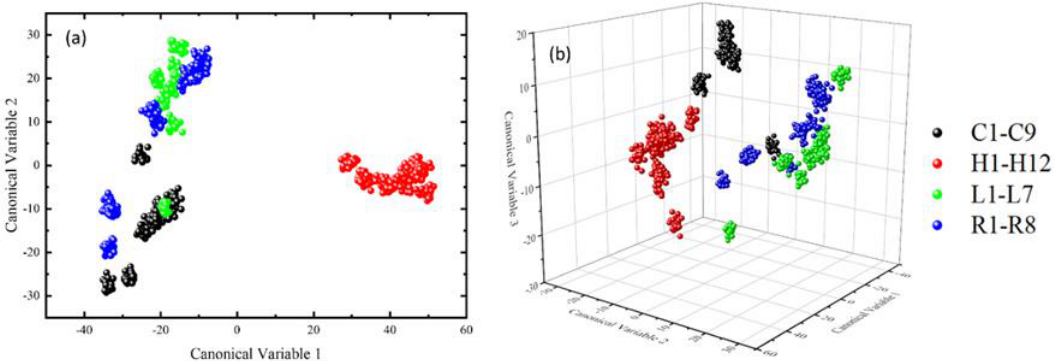
Figure 2. ( a ) 2D and ( b ) 3D LDA scatter plots corresponding to the olive oil samples from Chania (C), Heraklion (H), Lasithi (L) and Rethymnon (R) regions.